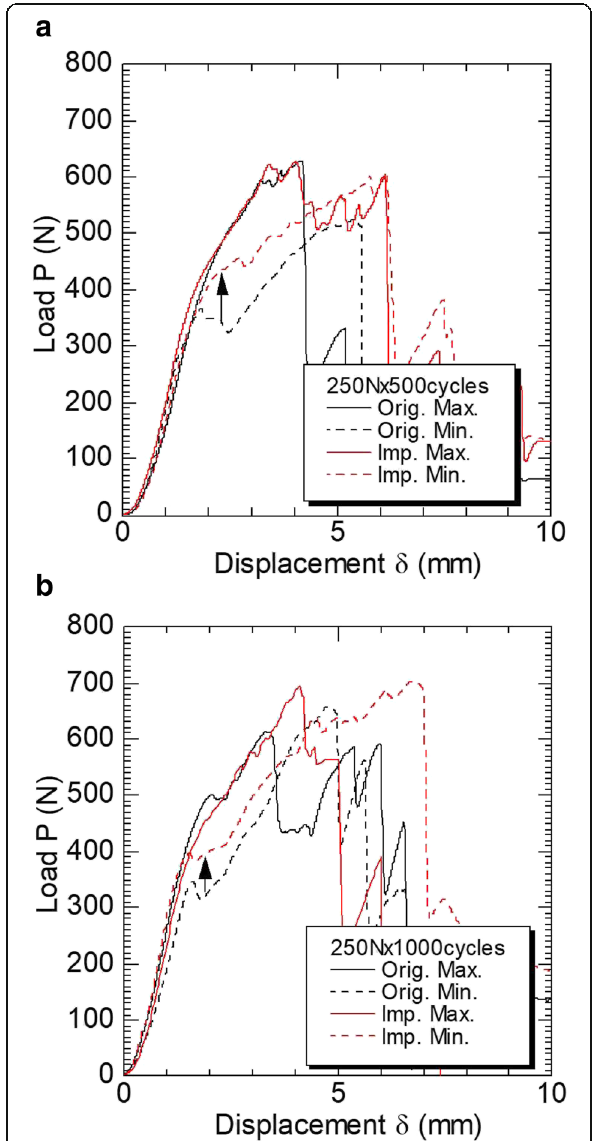
Fig. 4 Load-displacement behaviors original and improved EndoButton after ( a ) 500 and ( b ) 1000 loading cycles (0-250N). The load-displacement behaviors of the sutures of each type of EndoButton were similar after 1000 loading cycles, as was the case with 500 loading cycles. In the case of the slip resistance of the suture is Maximum (Max.) force, both EndoButtons showed almost same resistance in the first peak. In contrast, in the case of the slip resistance of the suture is Minimum (Min.) force, the improved (Imp.) EndoButton showed higher resistance than that of an original (Orig.) EndoButton (Black